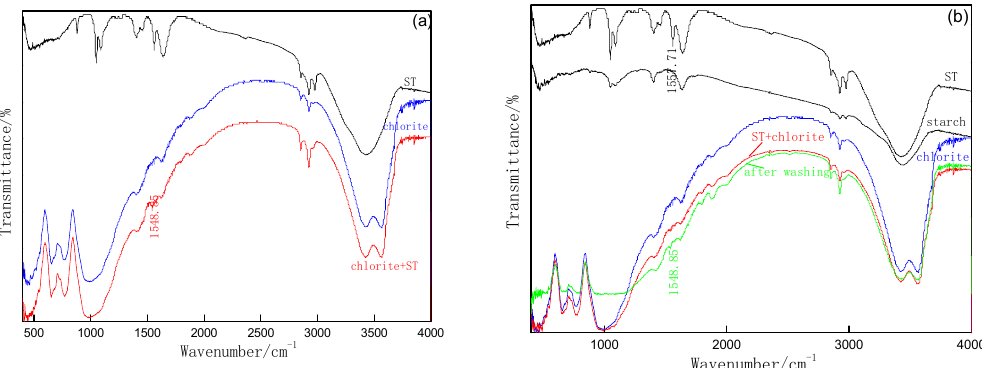
Figure 16. Infrared spectra of chlorite before and after the action ( a ) toluenesulfonamide(ST) and ( b ) starch and toluenesulfonamide(ST).